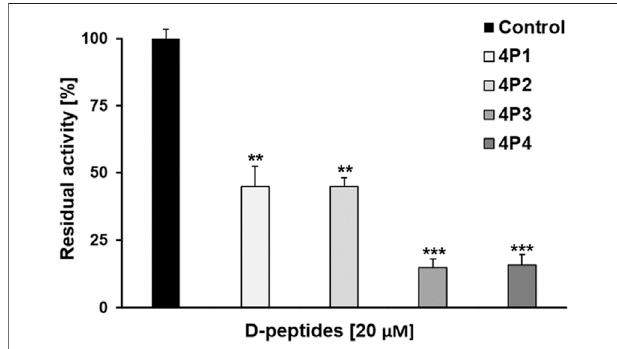
FIGURE5| Preliminaryinhibitiontestsof4P1-4against3CL pro .4P1and 4P2 inhibit the virus protease activity by more than 60%. 4P3 and 4P4 inhibit the virus protease activity more than 80%. Data shown are the mean ± STD from three independent measurements (n (cid:1) 3). Asterisks mean that the datadiffersfromthecontrol(0 µMinhibitor)signi fi cantlyat p < 0.01(**)and p < 0.001 (***), level according to ANOVA and Tukey ’ s